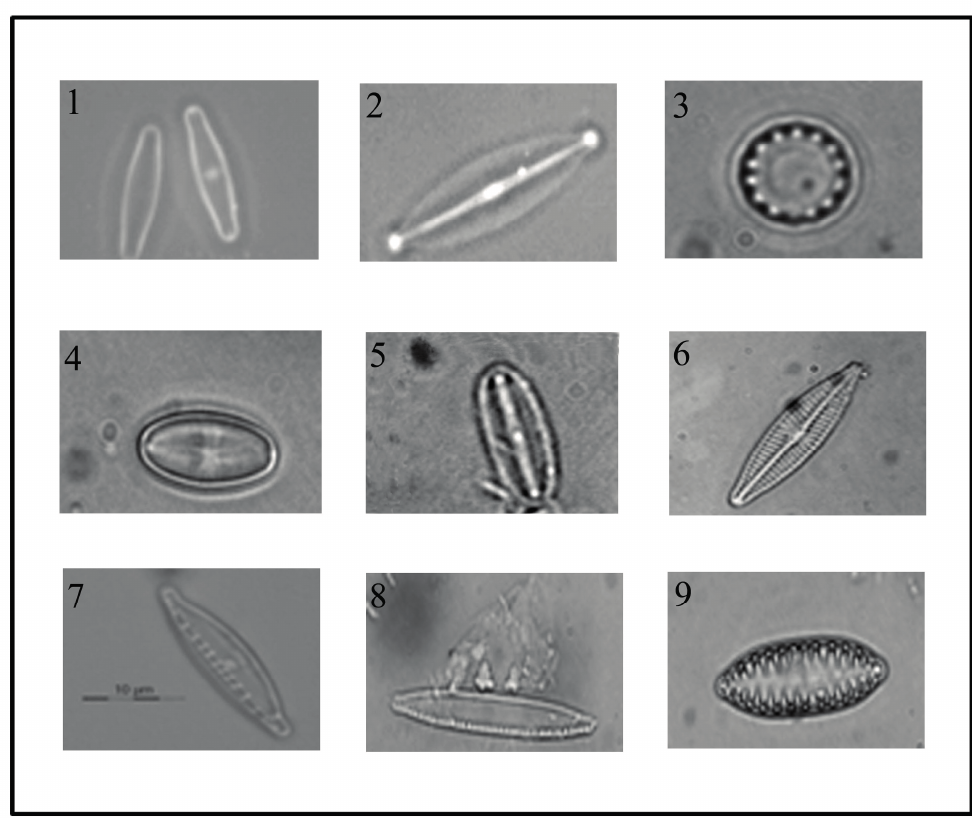
Figure 2. Photographs of the nine diatoms species used in this work: 1. Achnanthidium minutissimum; 2. Craticula halophila; 3. Cyclotella meneghiniana; 4. Eolimna minima; 5. Mayamaea atomus var. permitis; 6. Navicula veneta; 7. Nitzschia dissipata; 8. Nitzschia palea; 9. Surirella angusta. The pictures of diatom’s frustules were taken after removal of organic